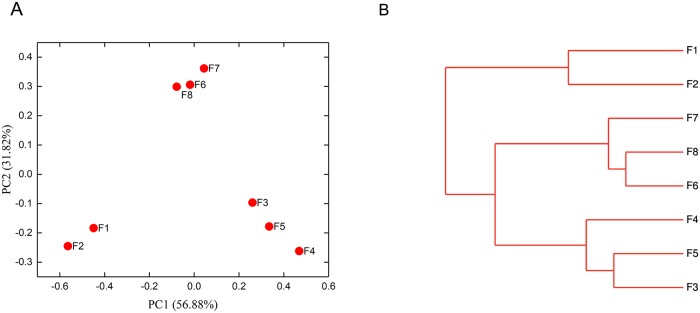
Bacterial structural analysis during the douchi fermentation process.(a) PCoA of the microbial communities, PC1 variance = 56.88%, PC2 variance = 31.82%. (b) Cluster analysis of the bacterial microbiota involved in the douchi fermentation process. Green indicates samples belonging to group 1 and red indicates samples belonging to group 2.